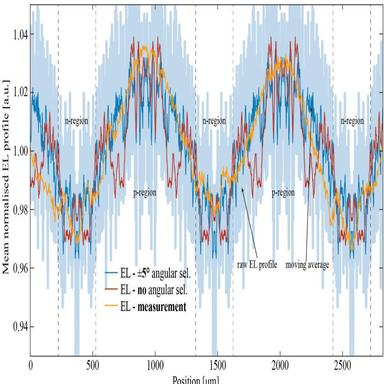
Effect of the angular selectivity of the imaging system – In the red case no angular selectivity was applied. In the blue case only rays incident upon the sensor at angles smaller than ±5◦ were considered. The referential measurement is shown in orange. (For interpretation of the references to colour in this figure legend, the reader is referred to the Web version of this article.)